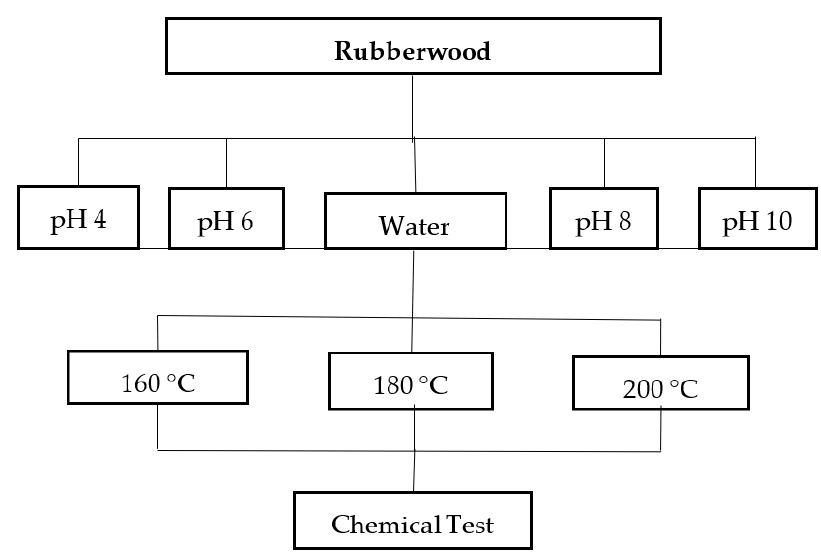
Figure 1. Schematic diagram of experimental design.